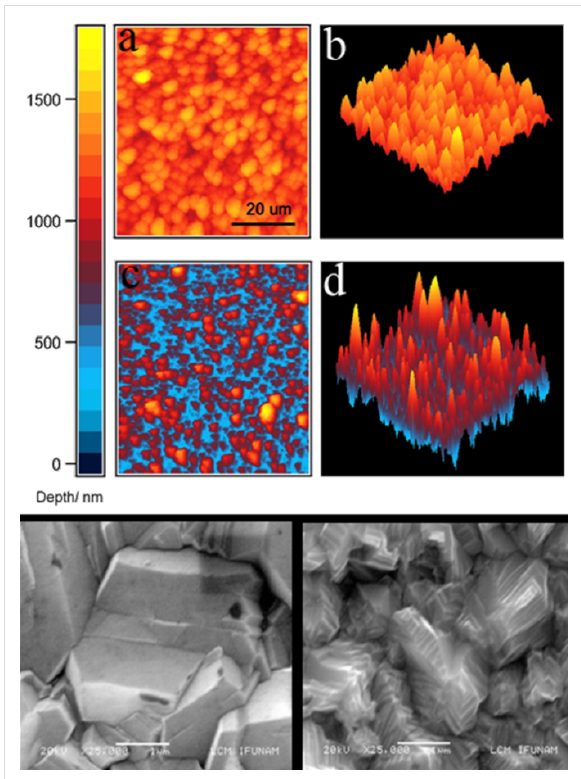
Figure 2: Top panel: AFM profiles of a 60 × 60 μ m 2 portion of the microcrystalline diamond film: (a,b) before and (c,d) after oxidation; reproduced with permission from [26], copyright 2013 Elsevier. Bottom grayscale panels: corresponding SEM images (scale bar = 1 μ m) of a typical microcrystal from the diamond film before oxidation (top image) and after oxidation, when a multi-scaled rough surface is obtained (bottom